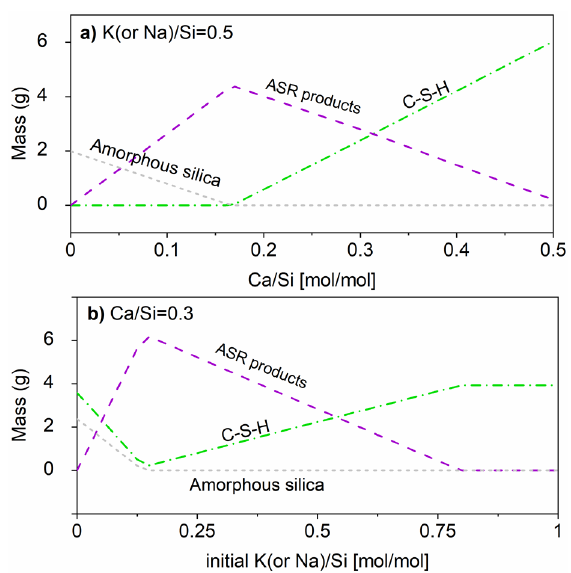
Figure 14. Chemical boundaries for the formation of ASR products: a) effect of alkali/Si ratio, b) effect of Ca/Si ratio. The symbols on the dashed lines are data calculated from thermodynamic modelling. Adapted from